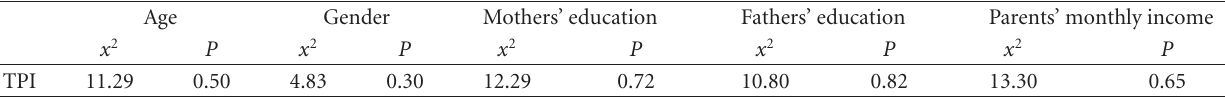
Table 5: Comparison of TPI and CPITN scores.